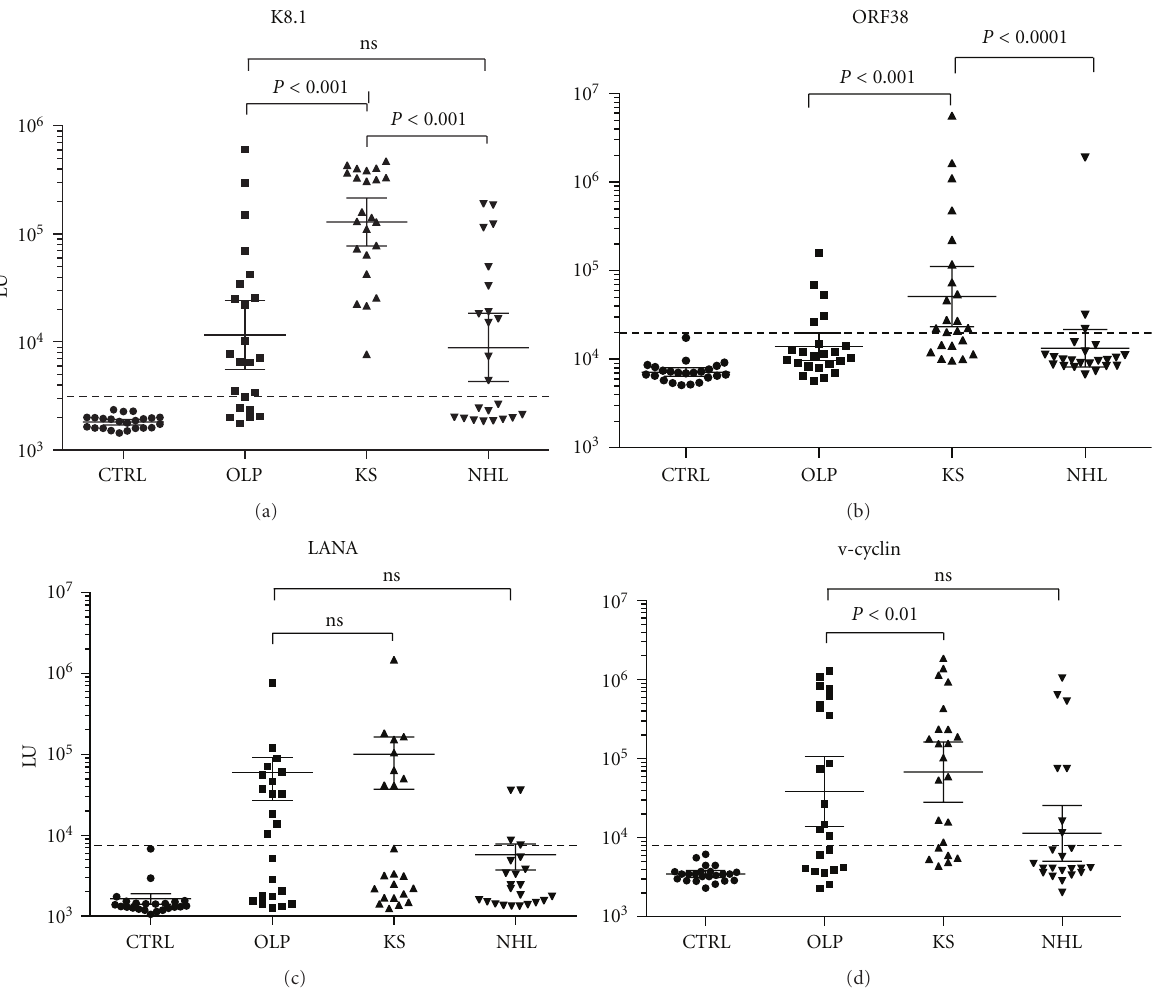
Figure 3: Profiling anti-KSHV antibodies. The antibody levels and 95% CI for (a) K8. 1, (b) ORF38, (c) LANA, and (d) v-cyclin antibodies, in the 23 control blood donors, 23 OLP, 23 KS, and 23 NHL subjects were plotted on the Y -axis using a log 10 scale. Each symbol represents a sample from one individual. The dashed line represents the cut-o ff level for determining seropositivity and is derived from the mean plus five standard deviations of the antibody values of the controls. P values for the di ff erent groups were calculated using the Mann Whitney U